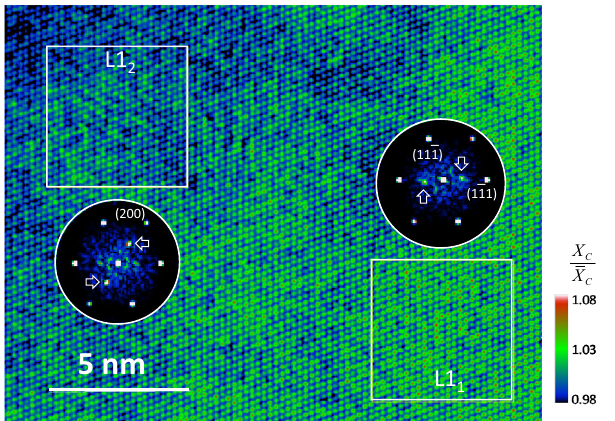
Fig.8|Evidenceofshort-rangeorderinginSampleWQfromatomicresolution imaging. The image is obtained by template matching of the spatially averaged atomic column with the recorded HAADF-STEM image, using the cross-correlation procedure described in Suppl. Note 8. The L1 1 and L1 2 SRO are detected in two boxedregions,asevidencedbytheirpowerspectra.Thecross-correlationimageis normalized with the mean equals to 1. The color bar indicates the range of the normalized cross-correlation coef fi cients ( X C